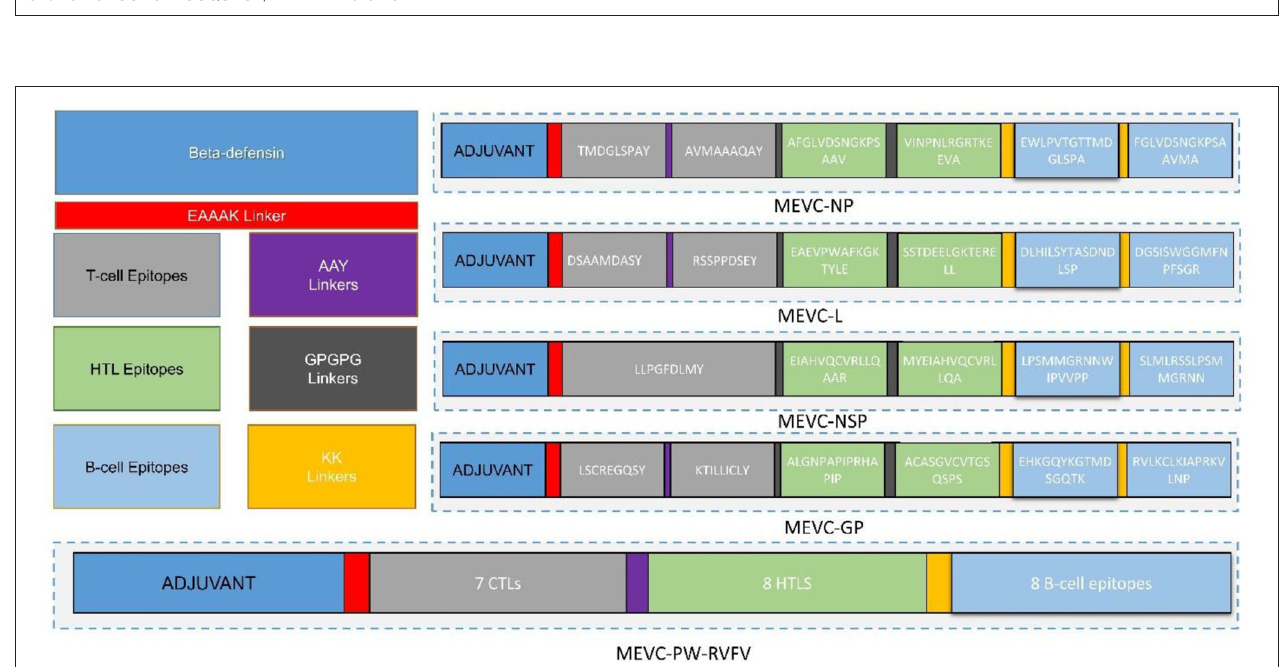
FIGURE 3 | Topological organization of MEVCs designed against RVFV. This includes the protein-specific and proteome-wide epitopes joined with concerned linkers in the anti-RVFV vaccine designs.